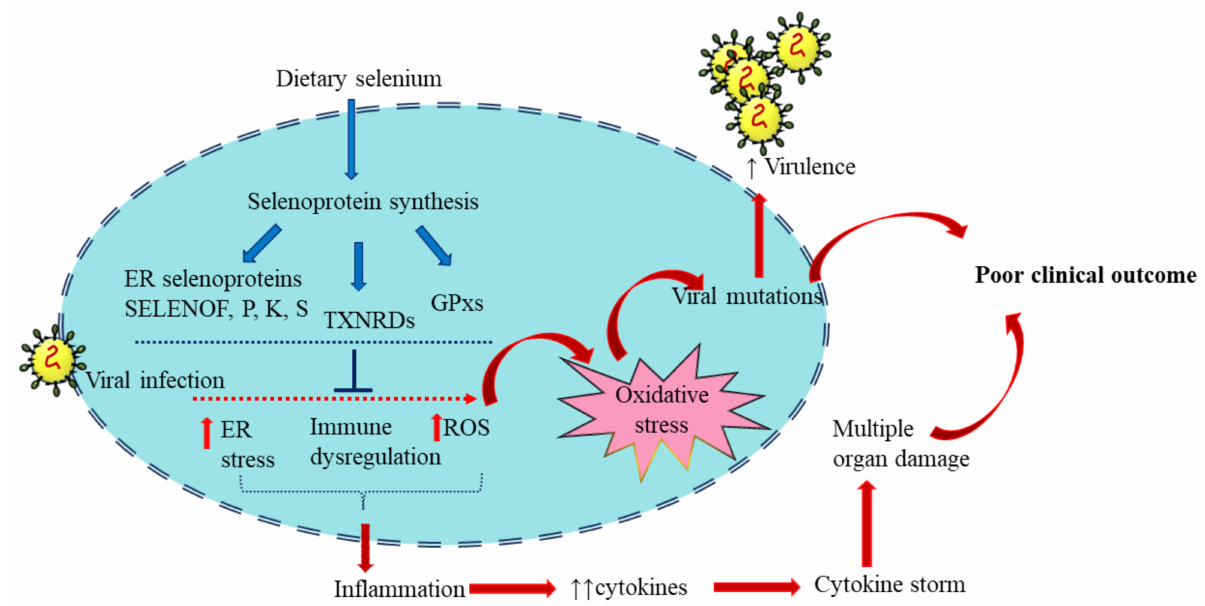
Figure 3. Selenoproteins in viral infection: Dietary selenium is incorporated in selenoproteins that play regulatory roles in immune function and redox homeostasis. These include the Selenoproteins glutathione peroxidases (GPX), 15 kDa selenoprotein F (SELENOF), selenoproteins K and S and thioredoxin reductases (TXNRD). Viral infection alters the expression of selenoproteins and induces oxidative stress, increasing virus virulence. The resultant inflammation and excess cytokine produc- tion eventually lead to poor clinical outcomes. The blue arrows represent the sequence of events of selenoprotein synthesis from dietary selenium. The red arrows represent the consequence of viral infection. Adequate selenium levels can reduce the impact of viral infection and help in an optimum antiviral